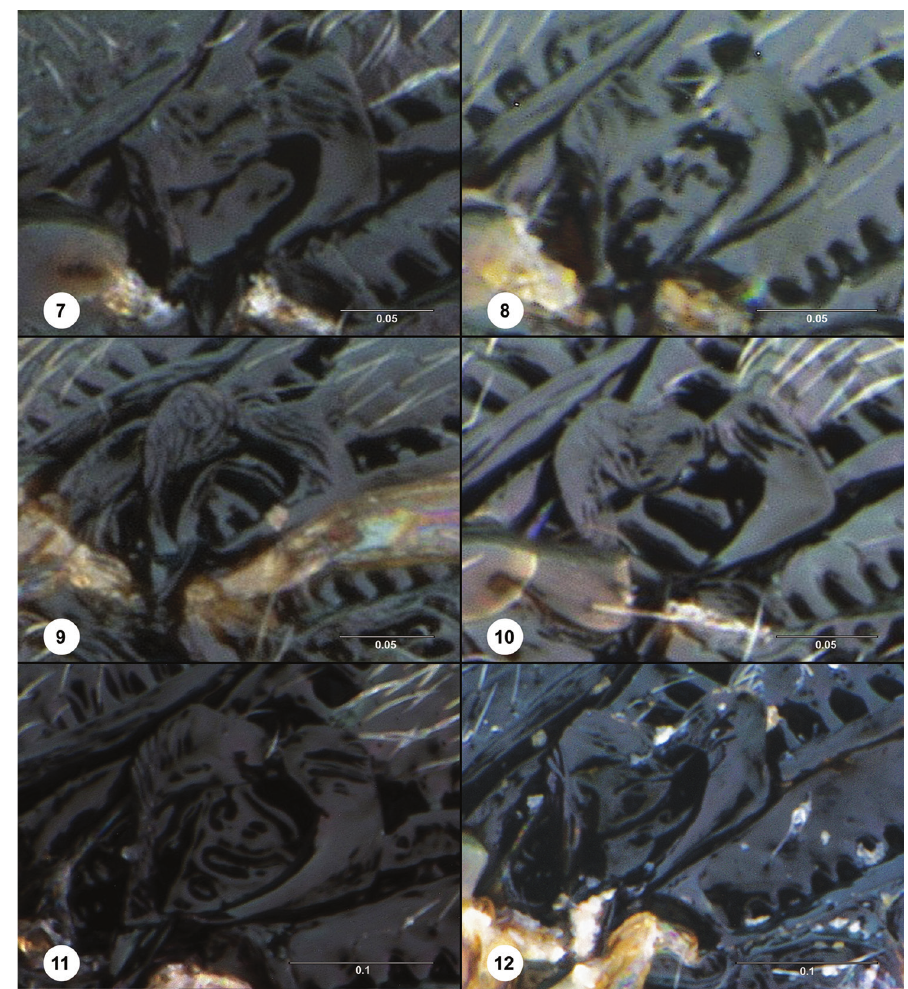
Figure 7–12. 7 T. mitsukurii , female (USNMENT00675722), axillar crescent, lateral view 8 T. tumidus , female (USNMENT00979425), axillar crescent, lateral view 9 T. flavipes , holotype of T. circus , female (ZMAS 0143), axillar crescent, lateral view 10 T. japonicus , female (USNMENT00675989), axillar cres- cent, lateral view. 11 T. saakowi , female (USNMENT00977544) axillar crescent, lateral view 12 T. nyc- teridaner , female (USNMENT00896178), axillar crescent, lateral view. Scale bars in millimeters. 6 Frons above antennal scrobe with irregular raised lines (Figures 92–93); mes- oscutum with microsculpture effaced posteriorly (Figure 91); median lobe of mesoscutum with oblique rugulae (Figure 91); mesoscutellum